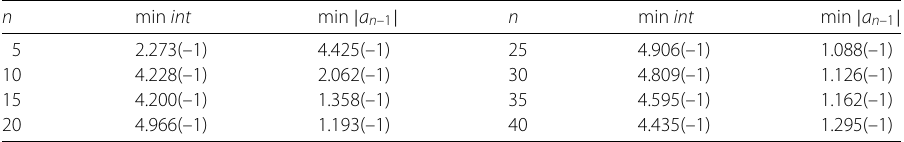
(cid:16) 1 y ( t )(1 – t ) d t | and | a n –1 | –1